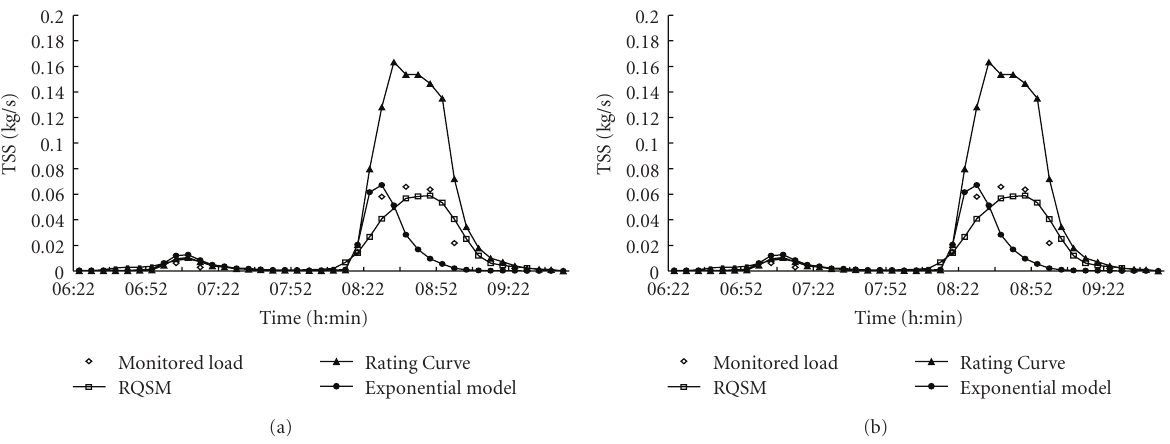
Figure 6: (a) Monitored rainfall and runo ff , and (b) simulated TSS pollutographs for June 23, 1980 rainfall event in South Mattis. Table 2: Physical characteristics of the four urban subcatchments used for the RQSM validation.